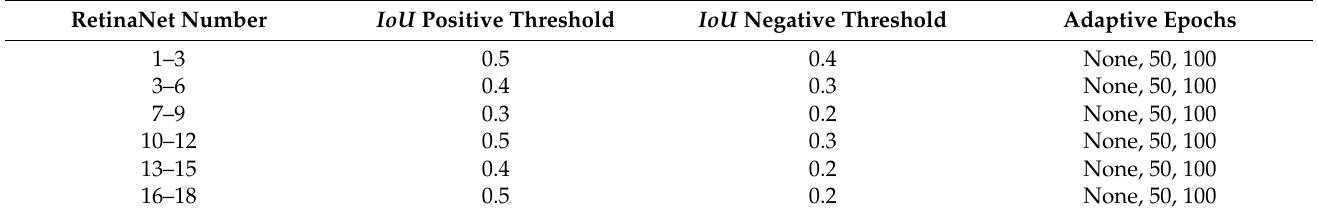
Table 2. Overview of the 18 network configurations investigated. Each IoU positive \ negative threshold pair was trained for the static case (None) or with an adaptive adjustment of 50 or 100